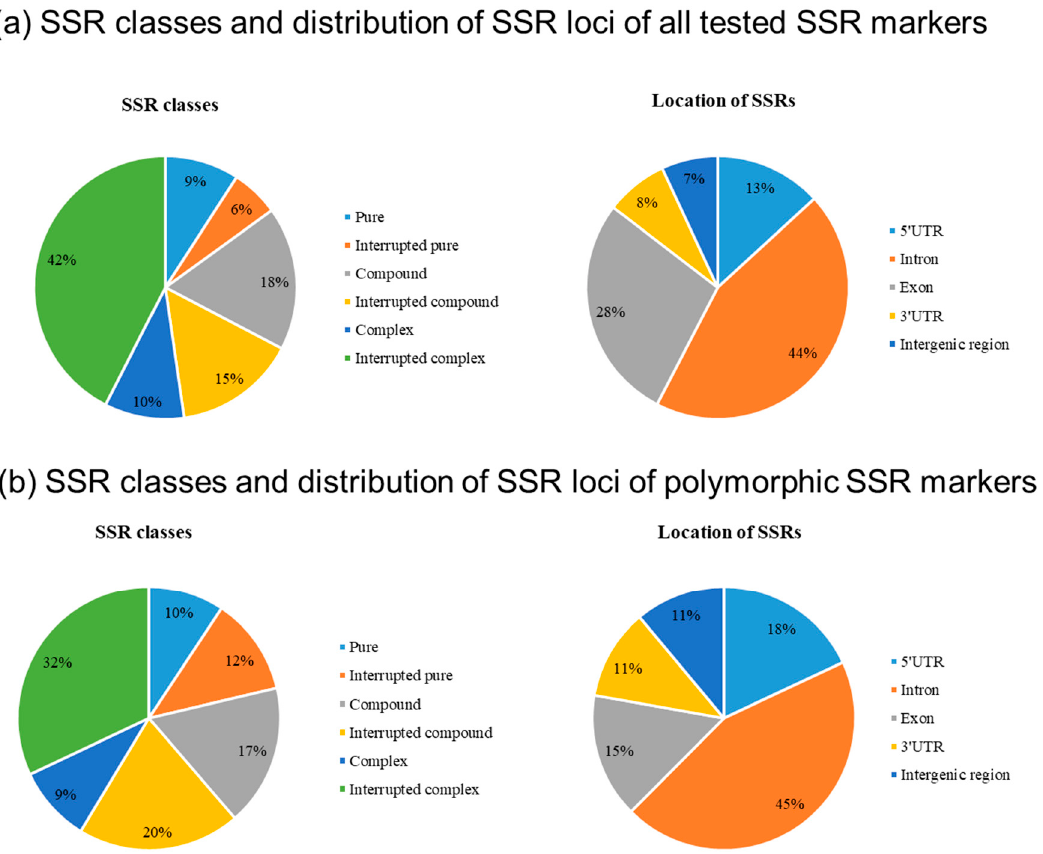
Figure 2. Composition and distribution of microsatellites in 5 (cid:48) -UTR-regions, exons, introns and 3 (cid:48) -UTR-regions of the investigated 103 candidate genes. ( a ) SSR classes and distribution of SSR loci of all tested SSR markers; ( b ) SSR classes and distribution of SSR loci of polymorphic SSR markers in the potato association panel (34 tetraploid potato cultivars). Only seven candidate genes for drought tolerance (PGSC0003DMG400021476, PGSC0003DMG400000284, PGSC0003DMG400021426, PGSC0003DMG400009719,